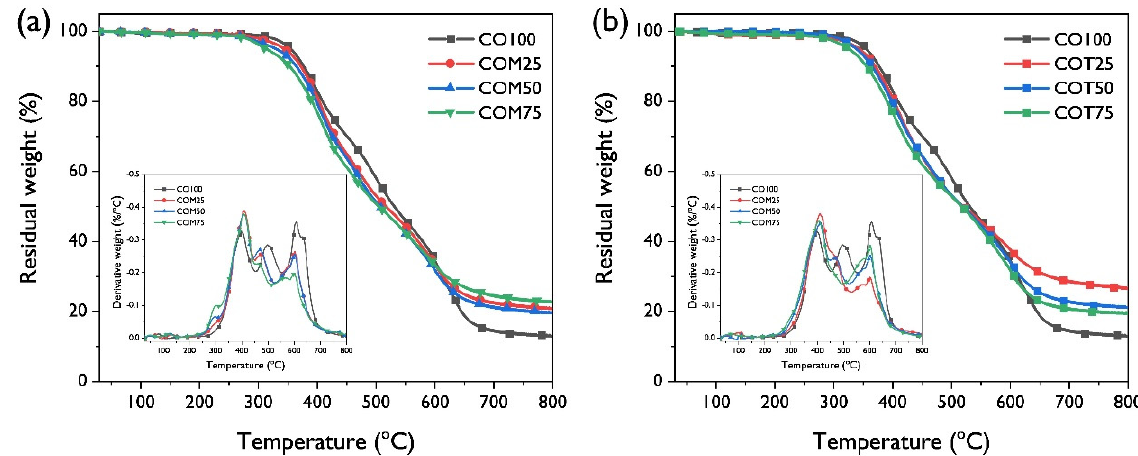
Figure 7. TGA thermograms and their derivative curves (inset) of the obtained PU foams using ( a ) COM and ( b ) COT.